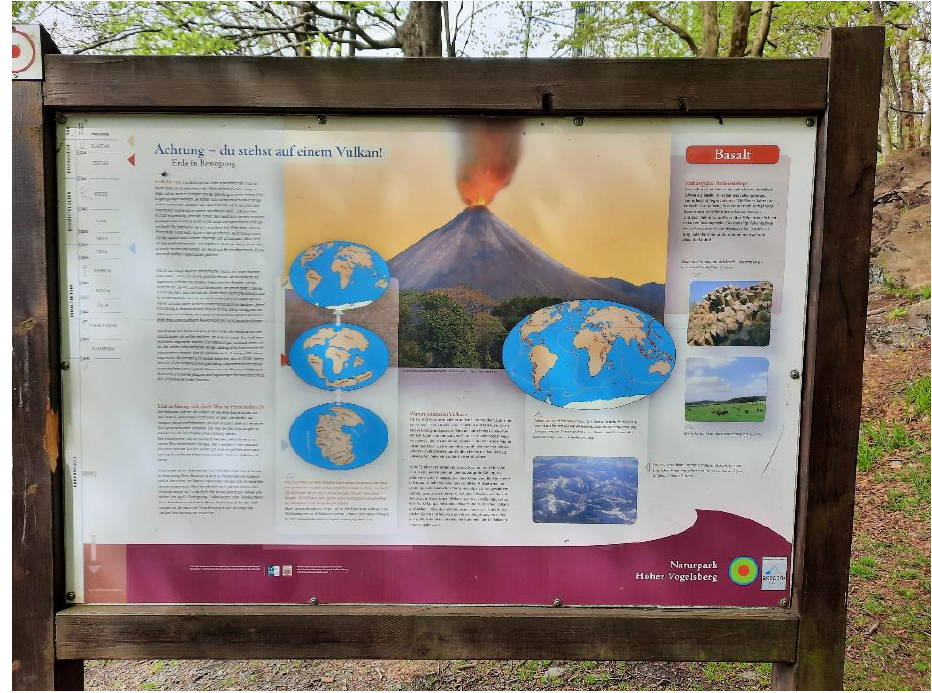
Figure 4. Marketing National GeoPark and Nature Park Vogelsberg (Copyright: Megerle 2021).